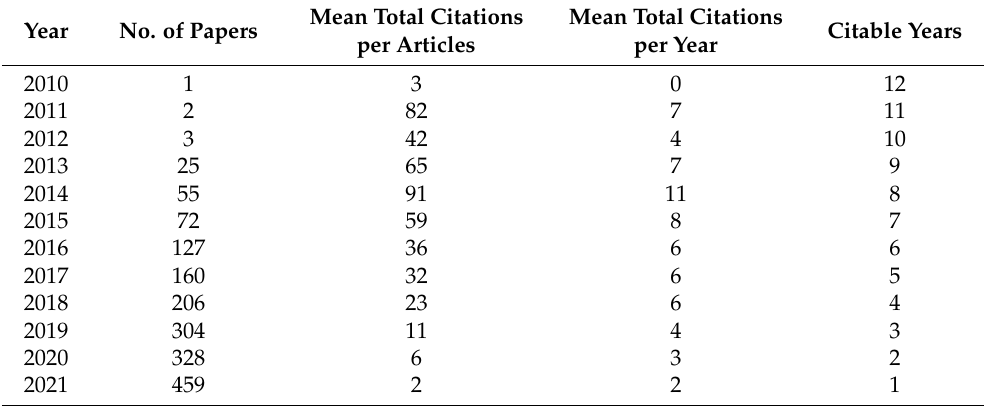
Table 2. Annual citations